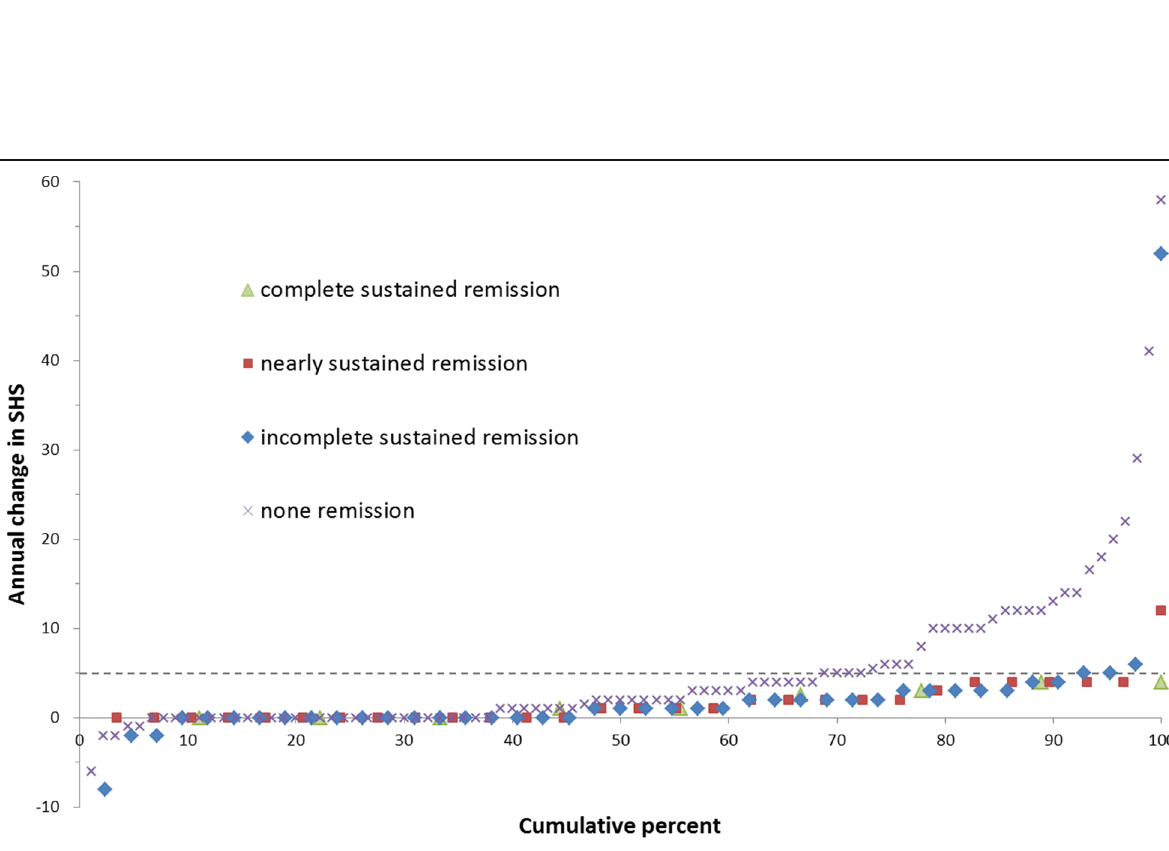
Fig. 2 Cumulative probability plot for patients in sustained remission according to CDAI criterion during follow-up